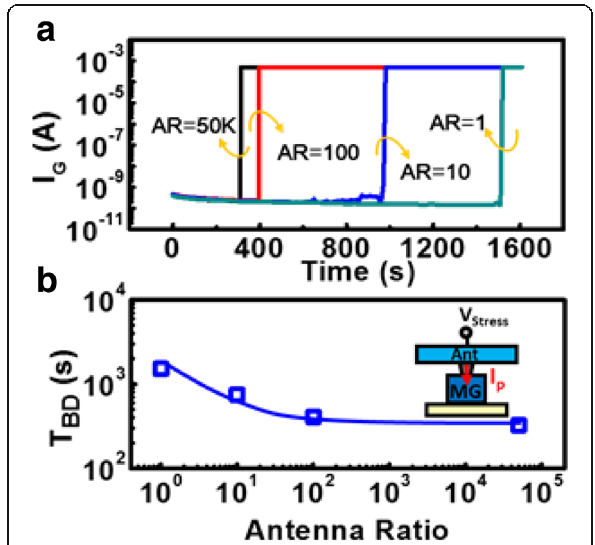
Fig. 10 a The time-to-breakdown characteristics I G vs time of the conventional PID detectors with the increasing antenna size. b T BD decreases drastically as AR exceeds